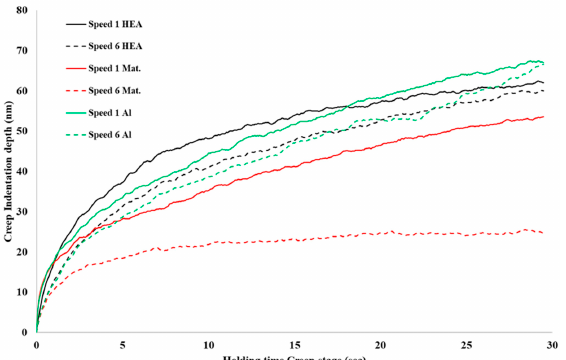
Figure 7. Actual depth of creep indentation as a function of holding time.